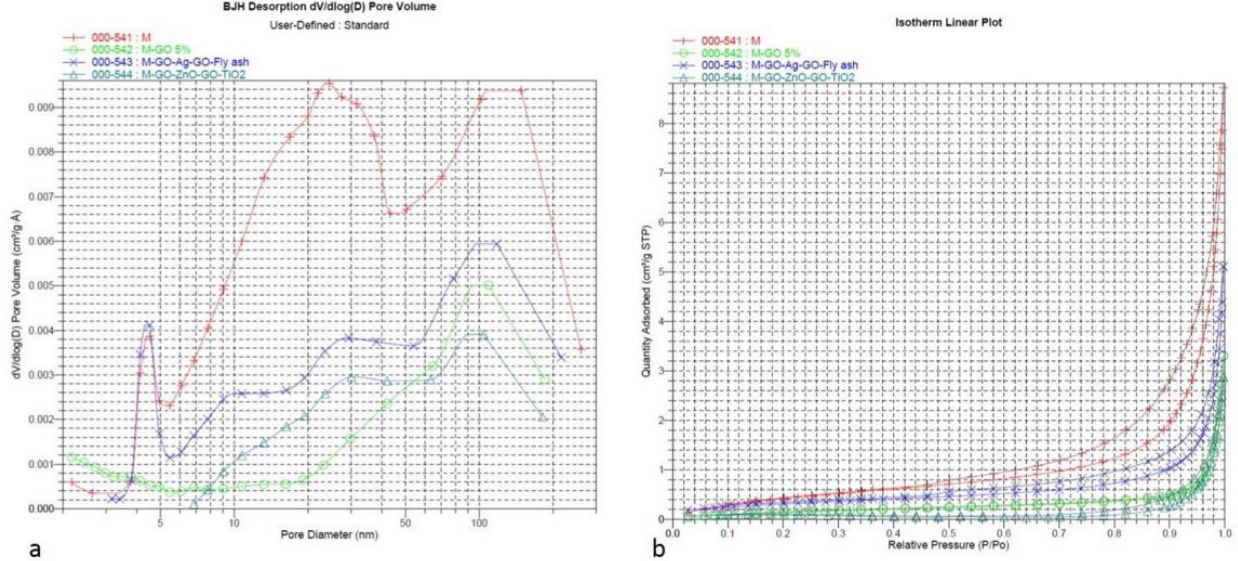
Figure 1. ( a ) Distribution and pore volume in mortars M, M2, M3 and M4 and ( b ) adsorption–desorption isotherms after 28 days.